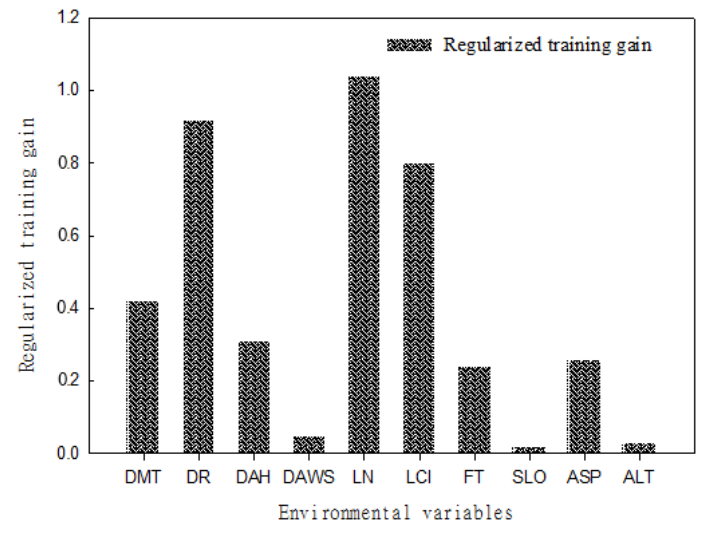
Figure 2. The relative contribution of environment variables to the model according to a jack-knife of regularized training gain (codes for the variables are as given in Table